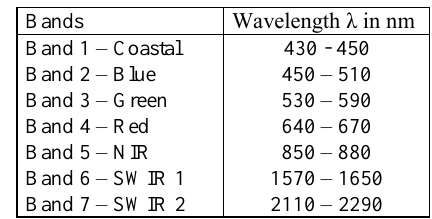
Table 1. Selected Landsat 8 bands with wavelength values